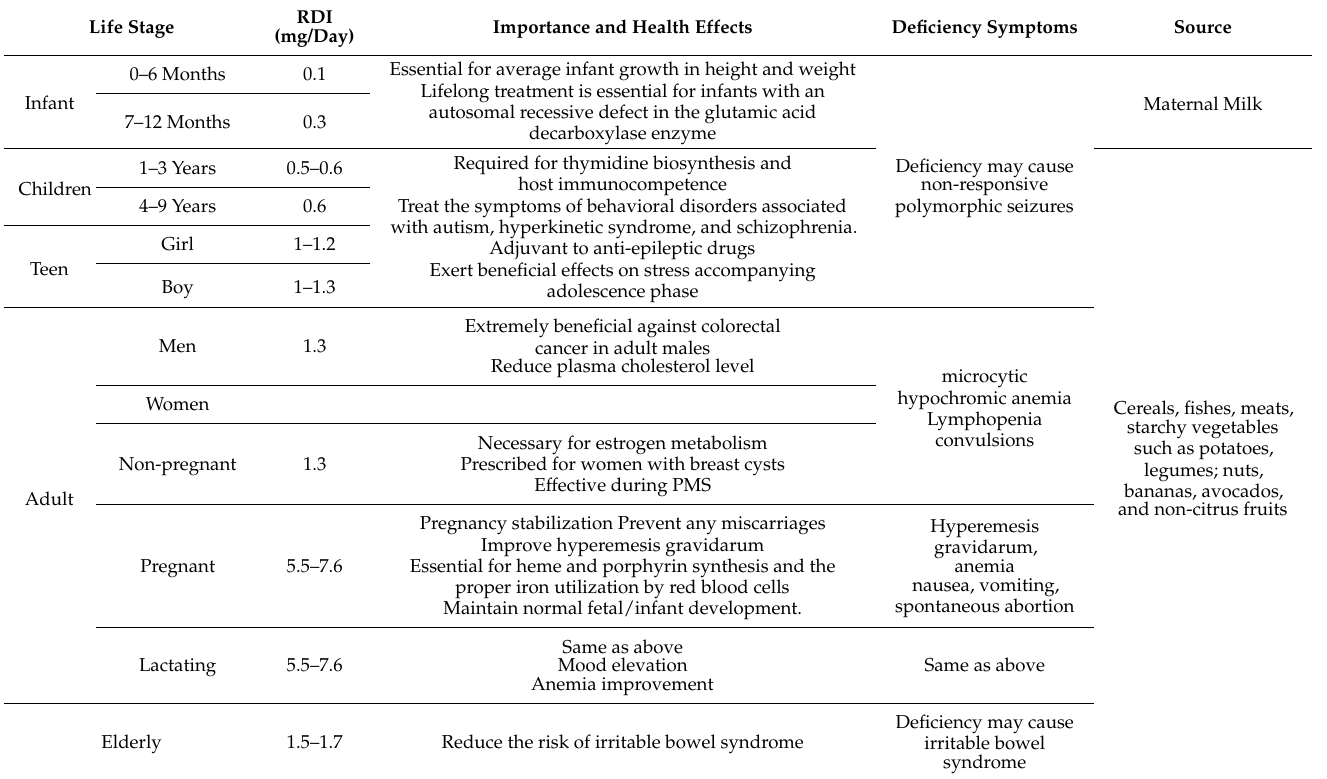
Table 5. Recommended daily intake (RDI), main actions, and natural sources of vitamin B6 (pyridox- ine) in different life